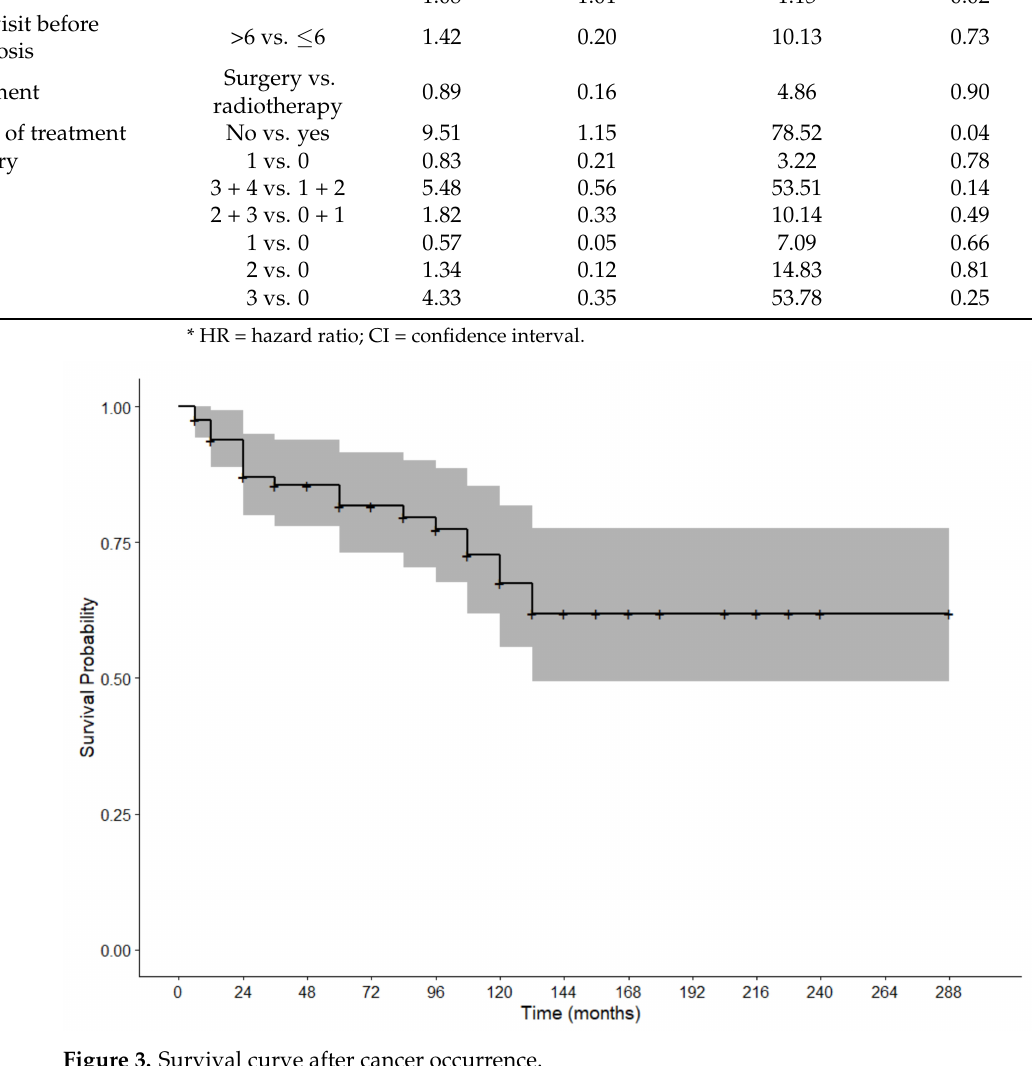
Figure 3. Survival curve after cancer